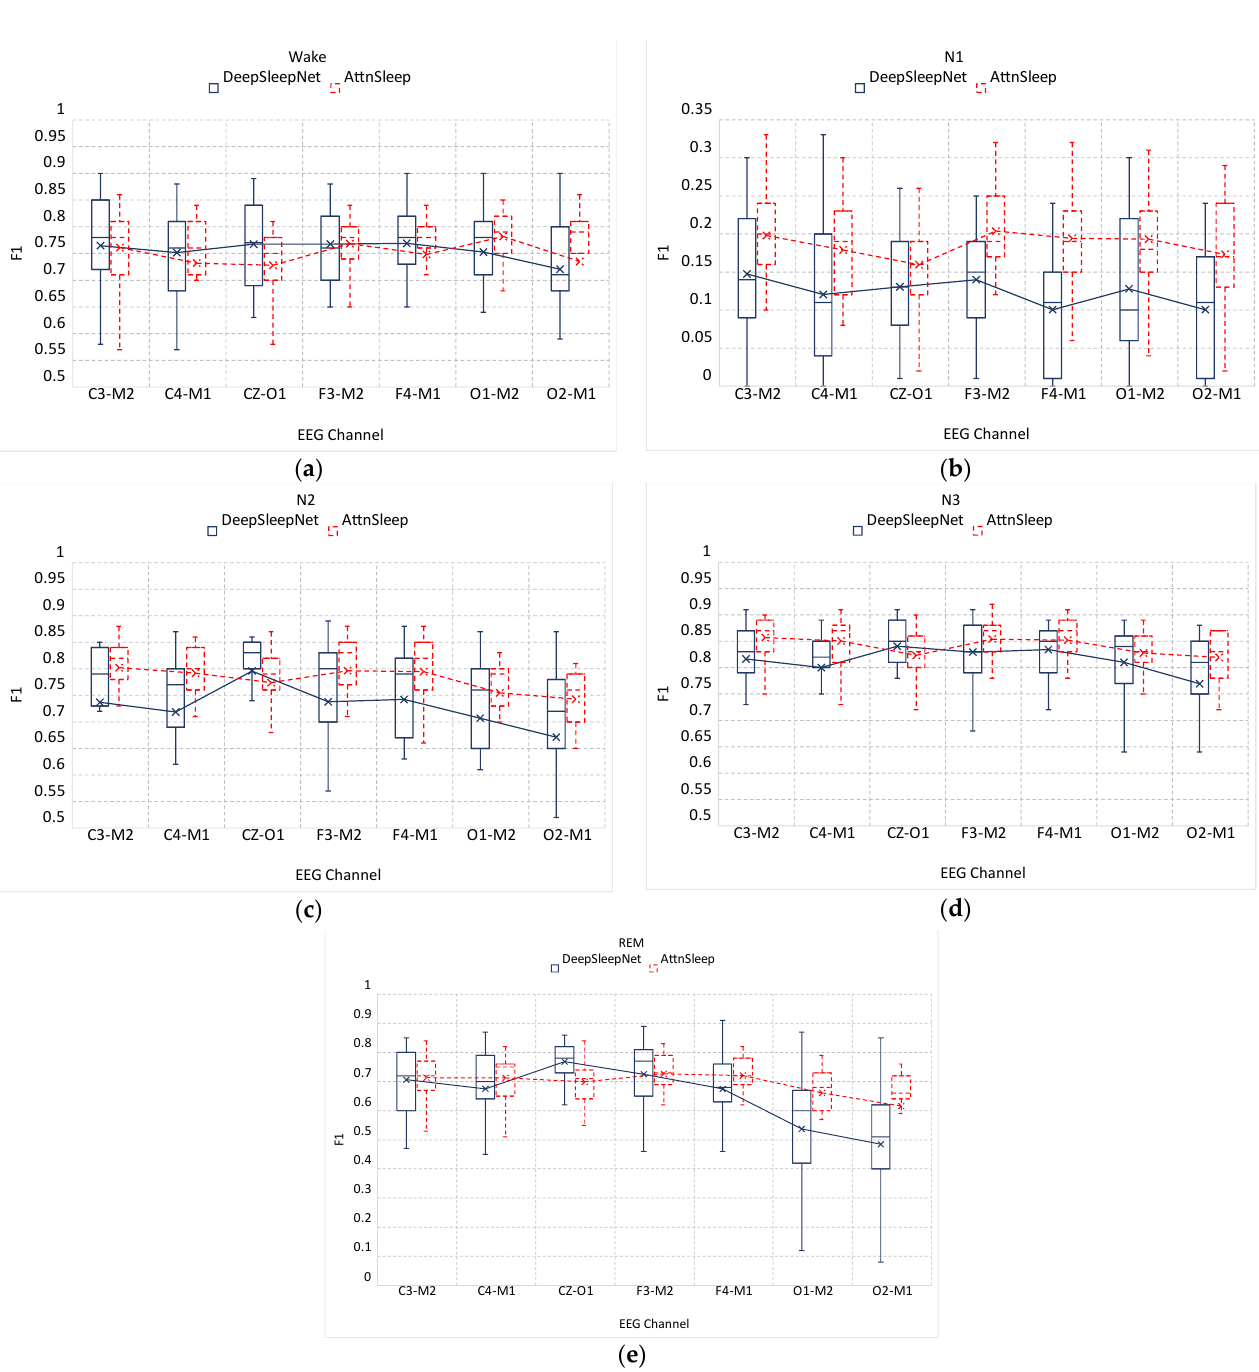
Figure 6. The DeepSleepNet (blue solid) and AttnSleep (red dashed) F1 scores over all age groups of the classification of the five sleep stages: ( a ) Wake, non-REM stages, ( b ) N1, ( c ) N2, ( d ) N3, and ( e ) REM. Overall, AttnSleep outperformed DeepSleepNet in the classification of almost all stages. N3 is the most accurate sleep stage while N1 is the most challenging one.